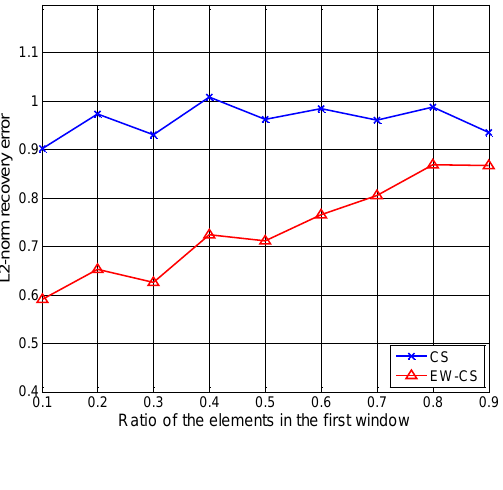
Figure 17. The l -norm recovery error with size of the first 2